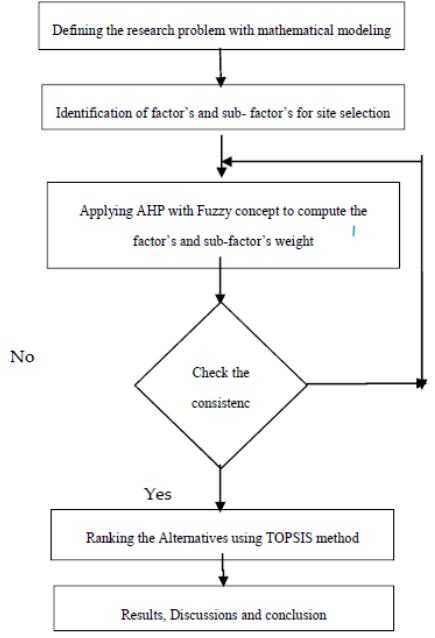
Figure 1. Flow chart for the proposed study.